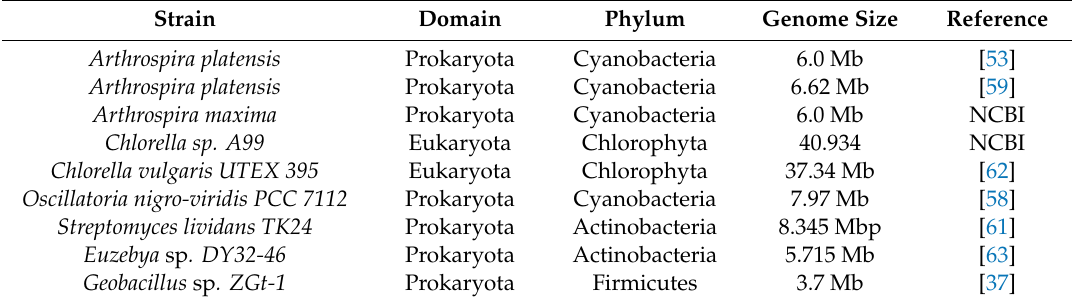
Table 1. Full genomes of selected bacteria and microalgal species available in